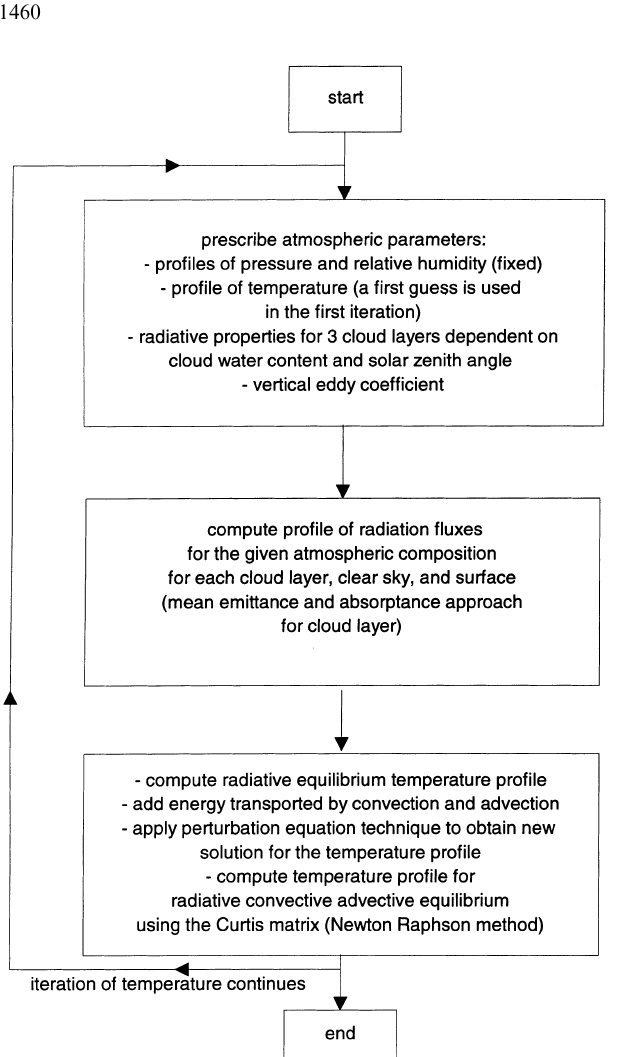
Fig. 5. Flow diagram showing the principle procedure of the RCM. Each iteration repeats the calculations of the vertical exchange coe(cid:129)cient and of the profile of the radiative fluxes on the basis of the new temperature profile. Advection is taken into consideration as a third energy flux besides radiation and convection in the modified version of the RCM which is used in